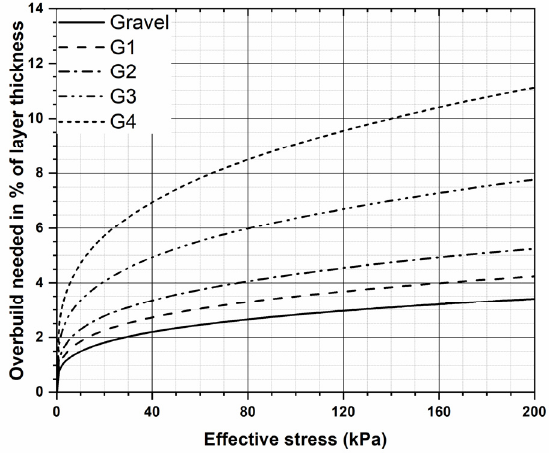
Figure 13. The percentage overbuild required for TDA-gravel mixtures with 0%, 5%, 10%, 20%, and 30% TDA by weight.